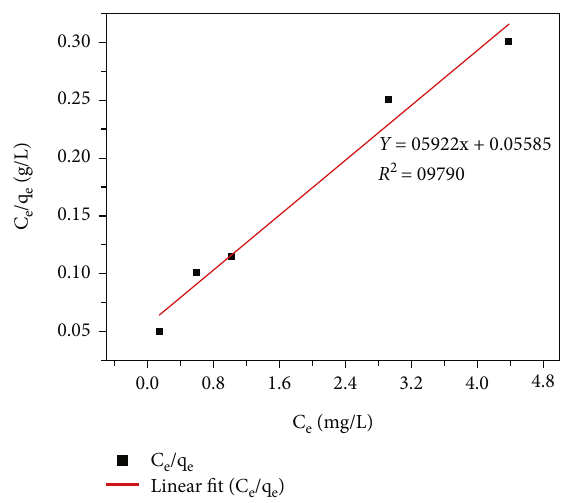
Figure 11: Langmuir Isotherm model for adsorption of Pb (II) on CMNB at pH of 6, contact time of 50 min, and bioadsorbent dosage of